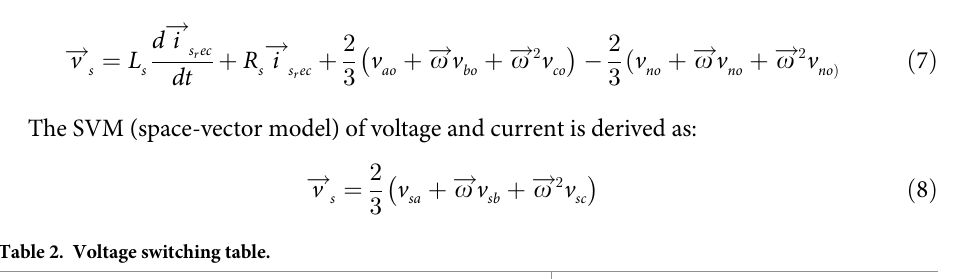
Table 2. Voltage switching table. Switching Combinations Voltage Vector